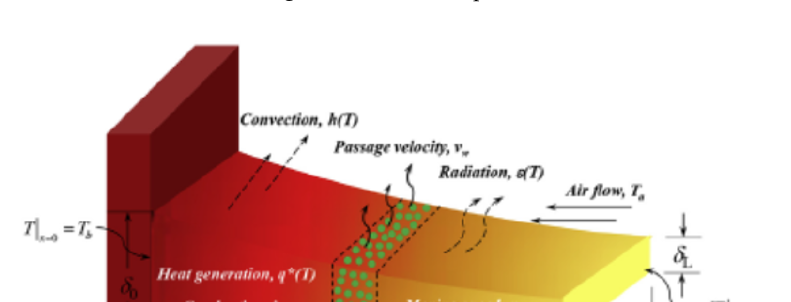
Figure 2. Convex fin profile